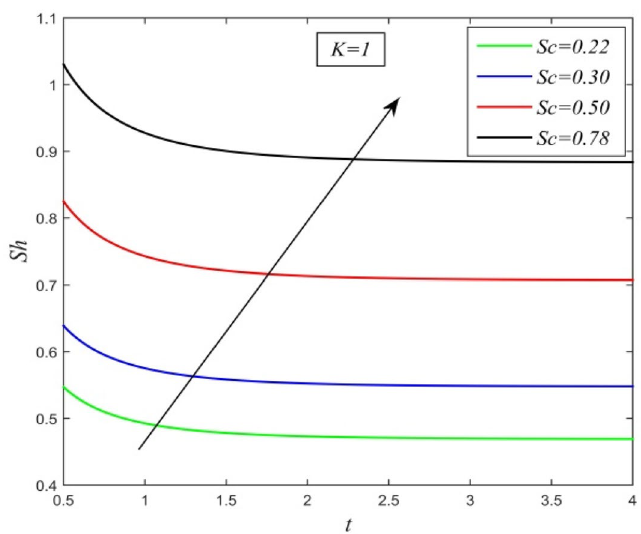
Figure 22. Sh versus t for different Sc and K =